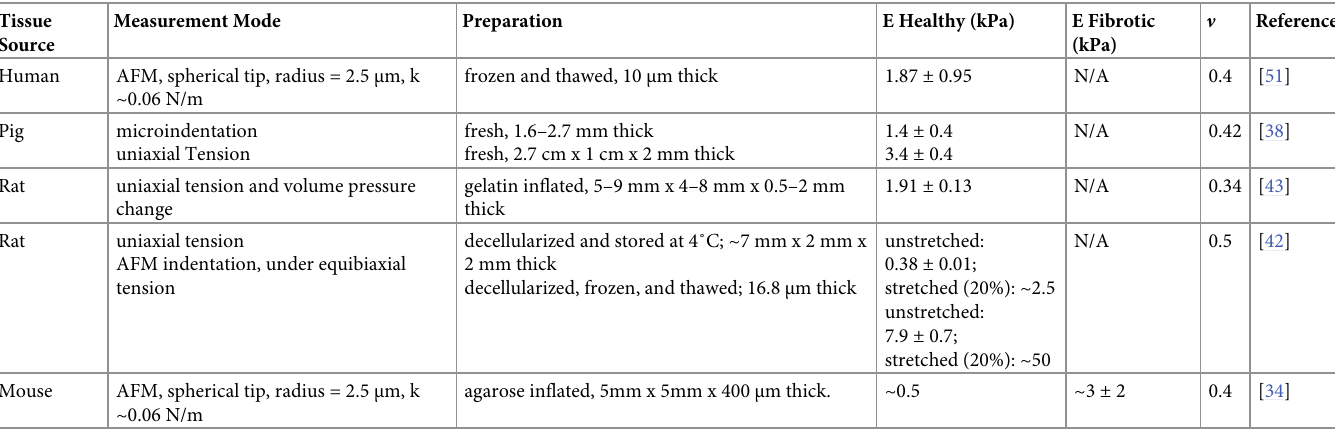
Table 1. Reported Mechanical Properties of Lung Tissue a .